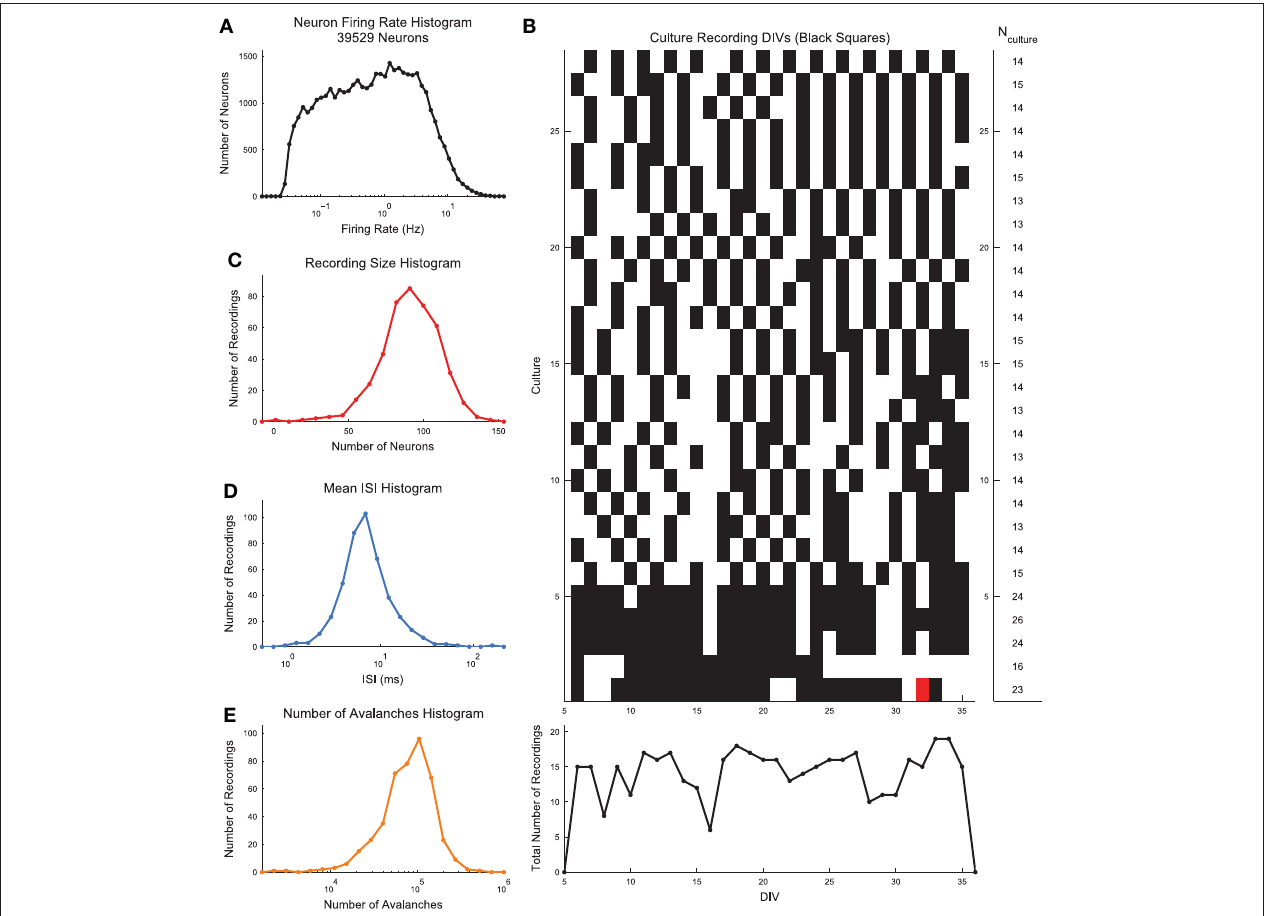
FIGURE 2 | Basic dissociated culture properties. (A) Neuron firing rate histogram. The histogram does not appear to be log-normal, though firing rates span multiple orders of magnitude and this distribution could result from the sum of multiple log-normal distributions and low firing rate bias in spike sorting. (B) Recording DIVs (black squares) for all cultures. White squares indicate no recording was performed. Red squares indicate the recordings that were excluded from the analysis due to too few avalanches. All other recordings were fully utilized in the analysis. (C) Histogram of number of recorded neurons across all recordings. (D) Histogram of mean network-wide interspike interval (ISI) across all recordings. Each recording was rebinned to the mean ISI. (E) Histogram of number of observed avalanches in each recording after rebinning to